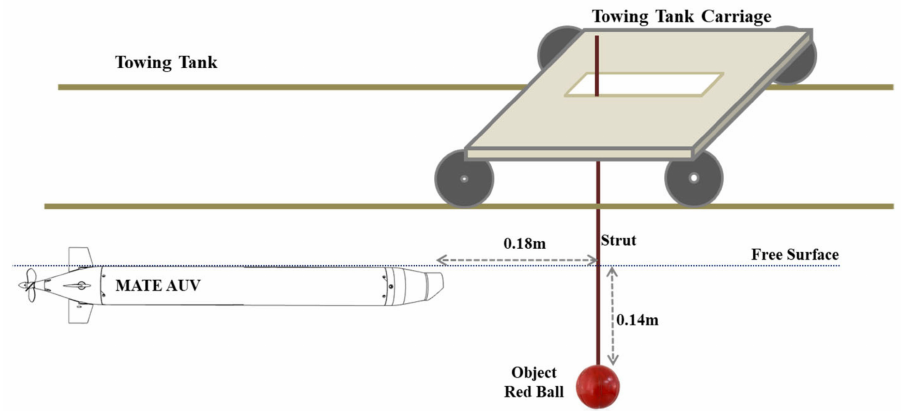
Figure 13. Schematic of the AUV and target object in the dynamic